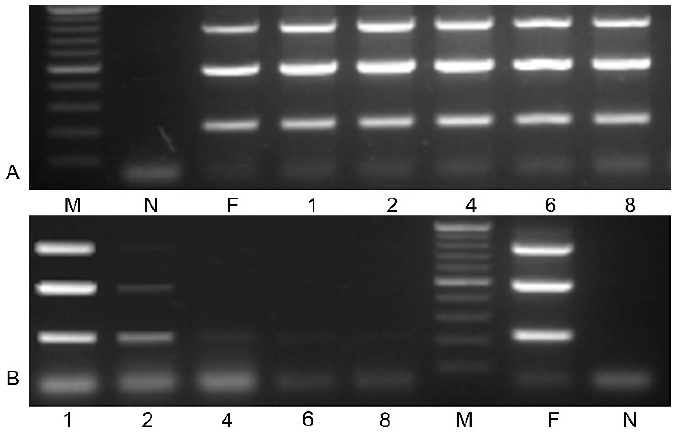
Figure 2. Stability of virus RNA2 in inoculum at 4 °C ( A ) and 21 °C ( B ) storage temperature (M—gene ruler 100–1000 bp; N—negative control; F—fresh inoculum; inoculum after storage 1–8 days. PCR mix without cDNA was used as a negative control.